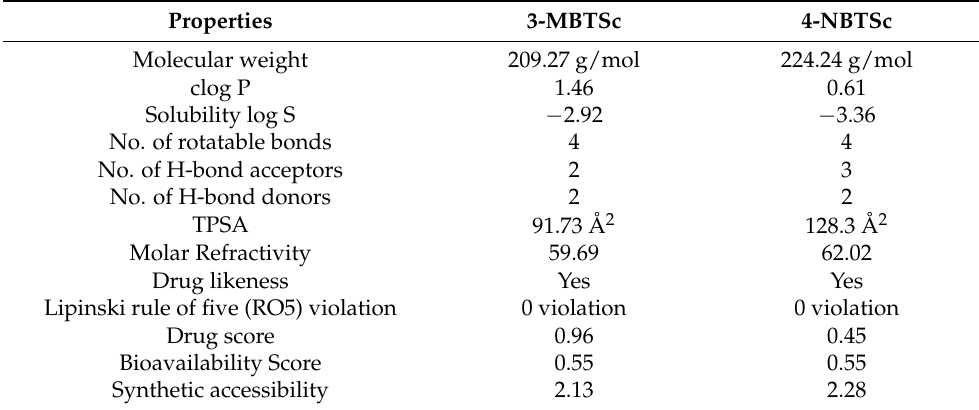
Table 2. Comparison of drug-likeness and medicinal chemistry properties of 3-MBTSc and 4-NBTSc from OSIRIS Property Explorer and